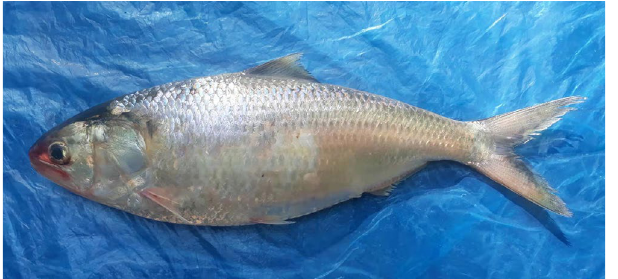
Figure 1. A Hilsa shad ( Tenualosa Ilisha) specimen collected from Chandpur (CP),